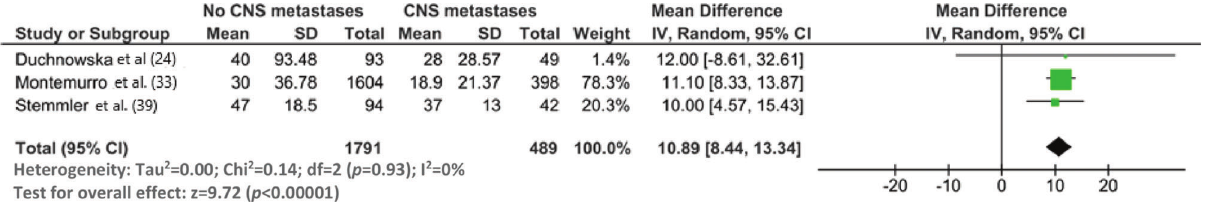
Figure S3 - Forest graph showing the results of the meta-analysis of the survival difference between MBC patients with and without CNS metastases.